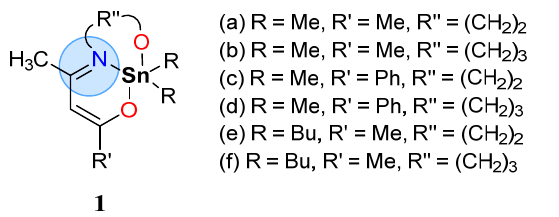
Figure 3. Diorganotin(IV) derivatives of some bioactive bifunctional tridentate Schiff base ligands. Prasad et al. obtained a similar result [80] when a series of four diorganotin(IV) complexes were synthetized using biologically active 4(3H)-quinazolinone derivatives as ligands (Figure 4) and the obtained compounds were screened against bacteria ( E. coli , S. aureus , R. solanacearum, and X. vesicatoria ) and fungi ( A. niger , A. flavus , F. oxysporum,